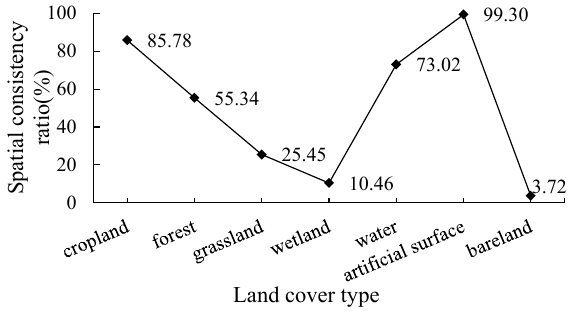
Figure 6. Spatial consistency ratio of land cover